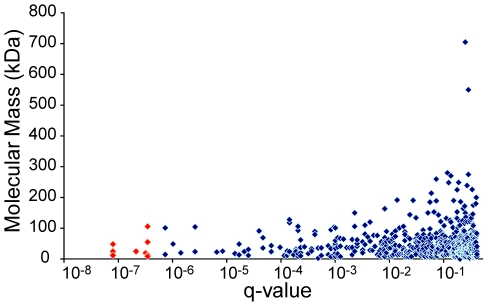
Comparison of a protein's molecular mass and the probability that it is a CKD biomarker (q-value (p-value corrected for false discovery rate)).